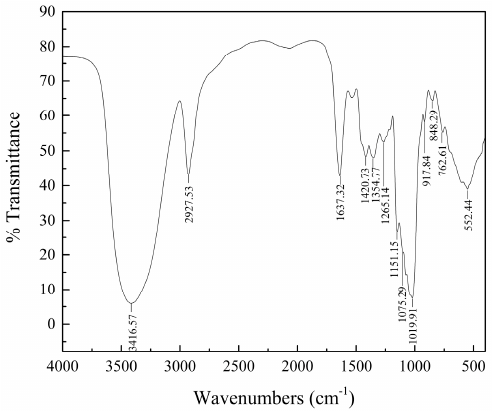
Figure 2. Results of IR spectrum on cAMPs-1A.